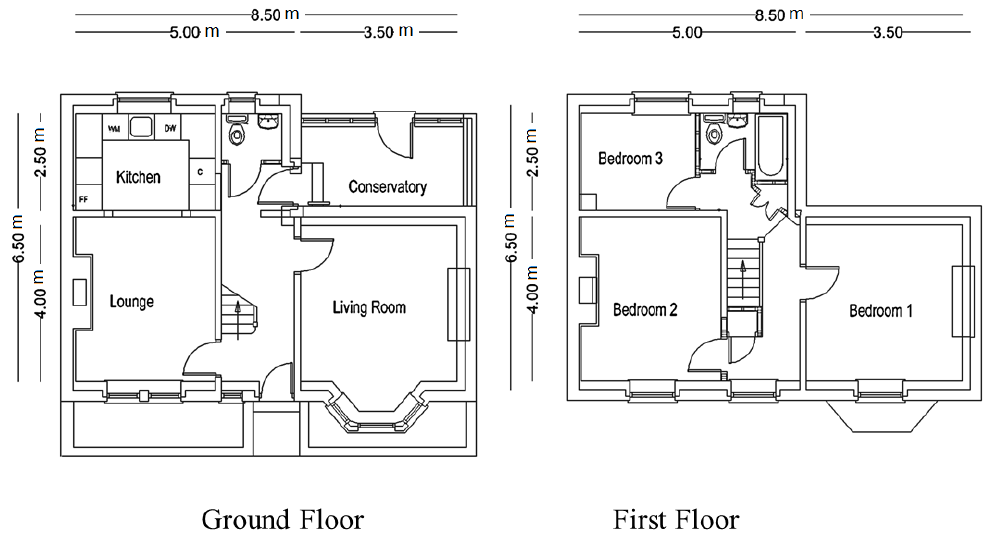
Figure 1. Terraced house